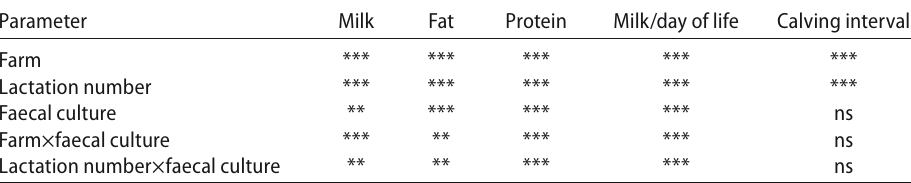
Significances of the influence of MAP status, farm, lactation number and interaction effects on milk in kg, fat in kg and protein in kg of the 305-day lactation and milk per day of life and calving interval Parameter Milk Fat Protein Milk/day of life Calving